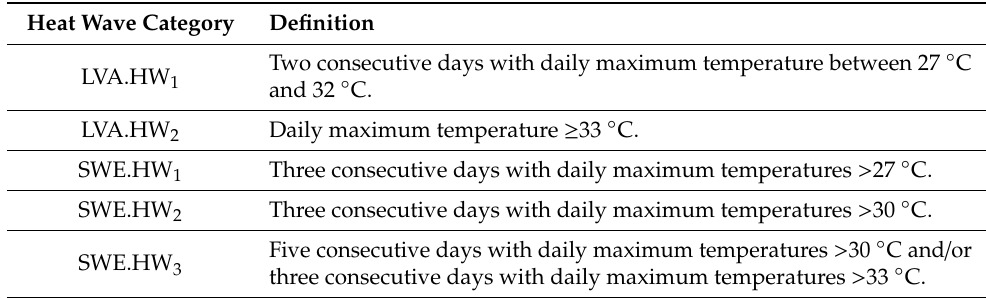
Table 1. Overview of heat wave variable